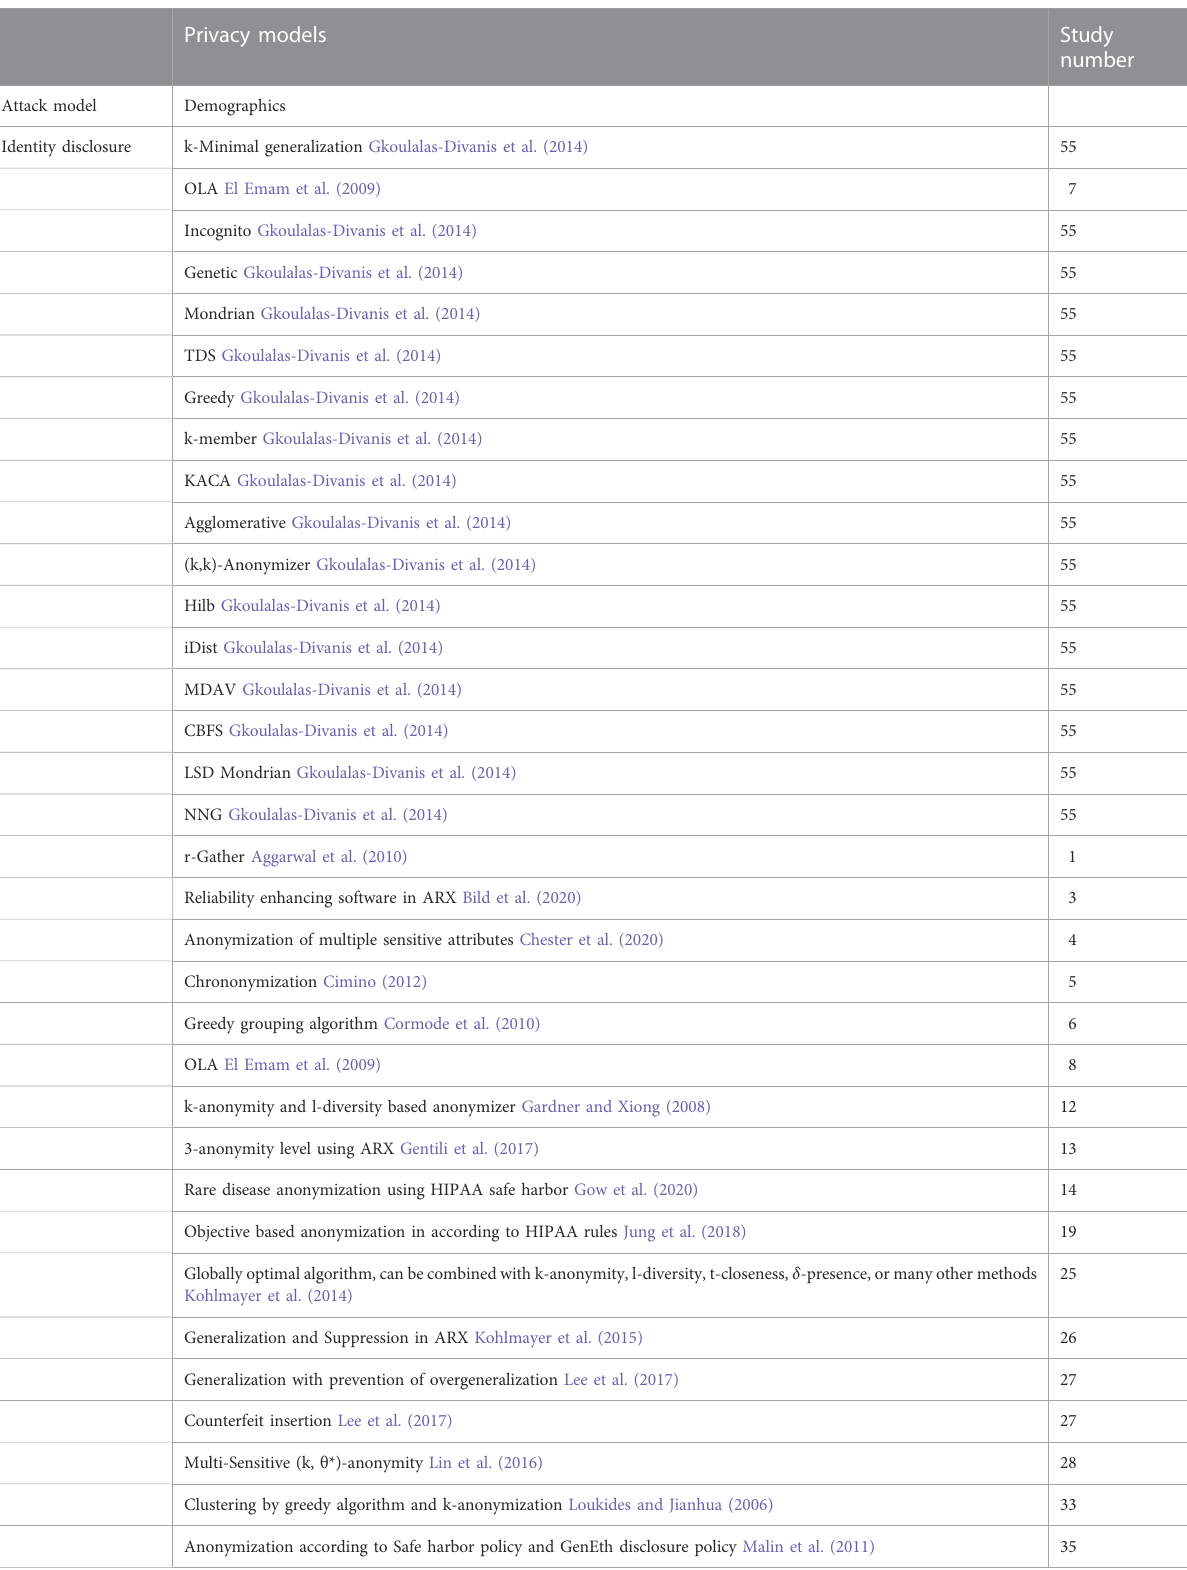
TABLE 1 Algorithms for the anonymization of structured healthcare data pertinent to demographic